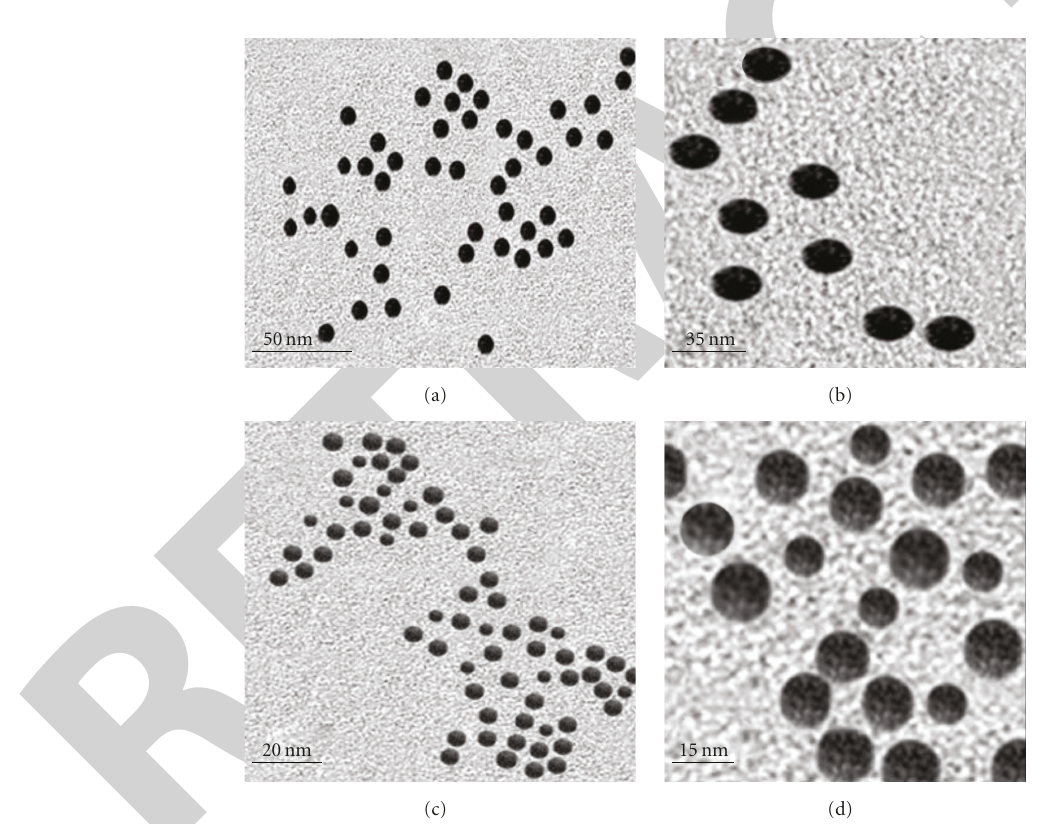
nanoparticles is reduced. In the 10 − 3 M, the size of the synthesized nanoparticle is 50 nm and 35 nm at 25 ◦ C and 60 ◦ C, respectively. Similarly, in the case of 10 − 4 M, the size of the synthesized nanoparticle is 20 nm and 15 nm at 25 ◦ C and 60 ◦ C,